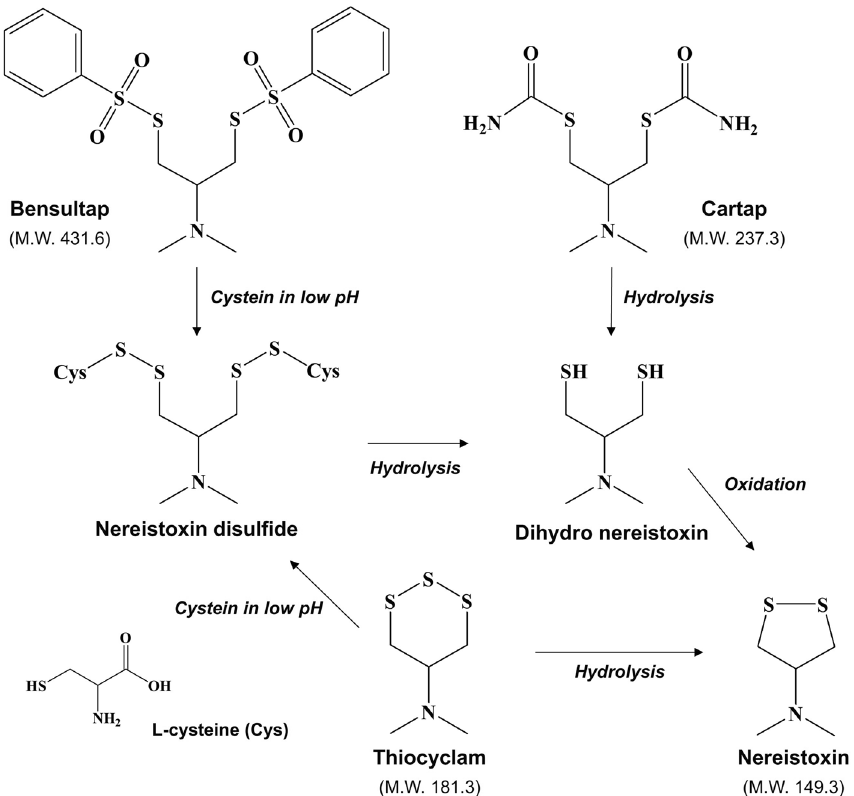
Figure 2. Conversion pathways of the nereistoxin insecticides during the pretreatment